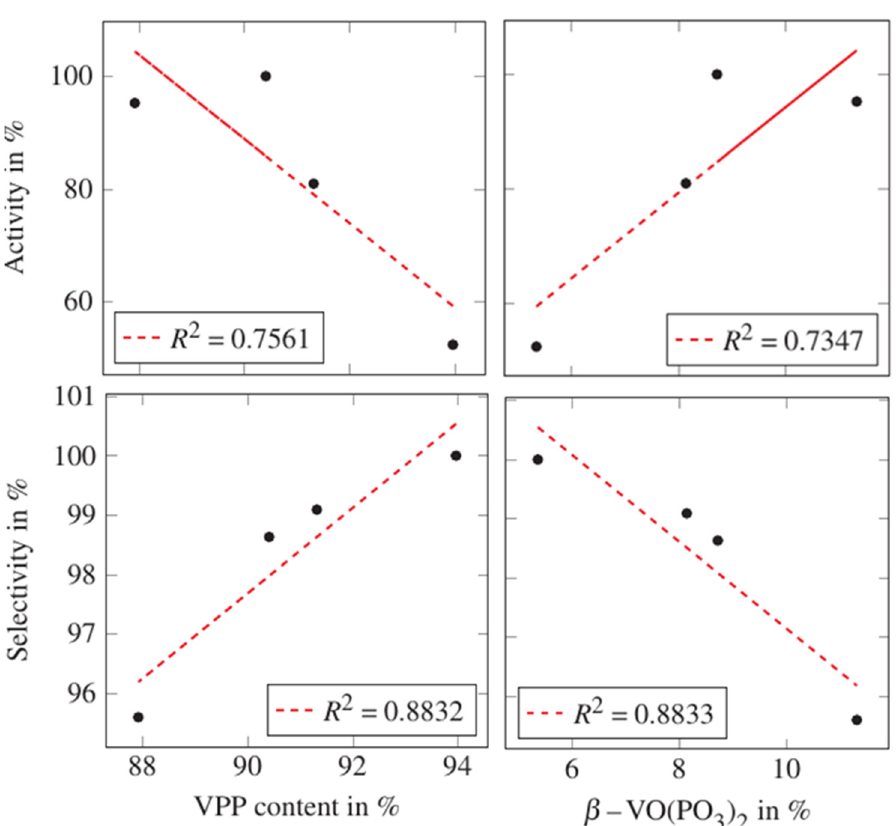
Figure 3. Correlation plots based on values gained by full profile refinement of XRD data collected after the catalytic test showing the correlation between the catalysts’ normalized activity and selec- tivity and the phase contents of VPP and β -VO(PO 3 ) 2 . The broken red line is the calculated linear regression line with R 2 being the corresponding coefficient of determination.